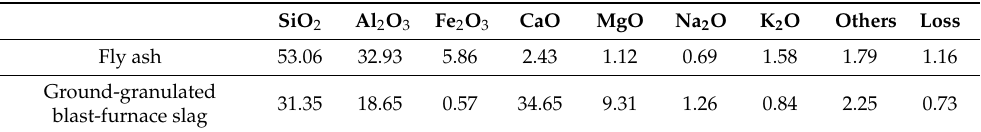
Table 1. Chemical composition (%).